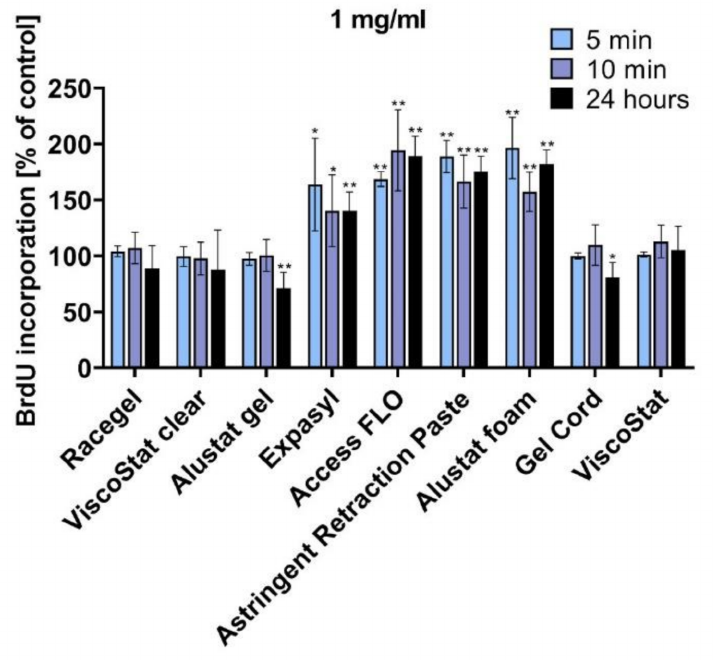
Figure 2. The cell proliferation detected by BrdU incorporation assay in human gingival fibroblasts after various time points of incubation (5 min, 10 min, and 24 h), with the gingival retraction agents diluted in the cell culture medium to 1 mg/mL concentration; * p < 0.05, ** p <